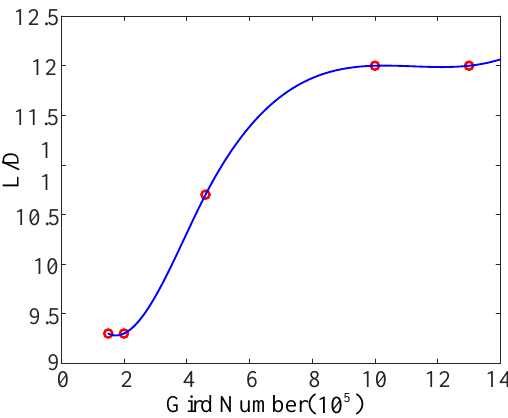
Figure 9. The effect of node number on lift-to-drag ratio.